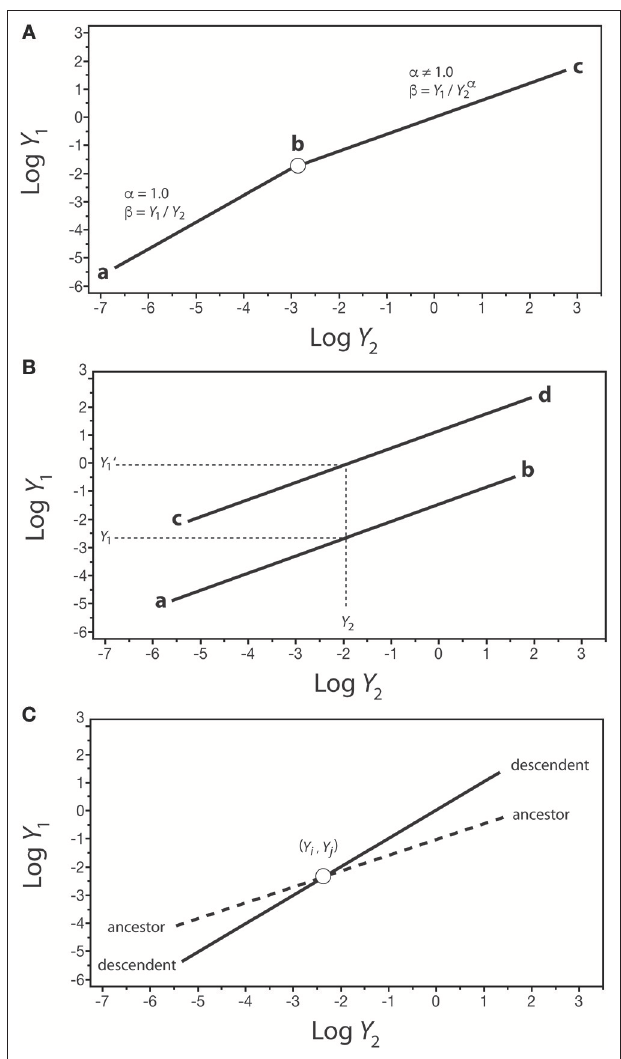
FIGURE 7 | Hypothetical scaling relationships between two body parts, Y 1 and Y 2 , showing changes in β – values over the course of development or evolution. (A) The shift between an ancestral isometric scaling relationship between Y 1 and Y 2 (denoted by the line a-b) and an allometric relationship in the descendent (denoted by the line b-c). (B) Two scaling relationships sharing the scaling exponent (denoted by lines a-b and c-d) but differing in β values. For any value of Y 2 , there exist two corresponding values of Y 1 (i.e., Y 1 and Y 1 ’). (C) An ancestor-descendent relationship (denoted by dashed and solid lines, respectively) in which β and α values change. If the ancestral body shape achieved at point ( Y i , Y j ) occurs earlier in the ontogeny of the descendent, development has accelerated. If the ancestral body shape achieved at point ( Y i , Y j ) occurs later in the ontogeny of the descendent, development has been